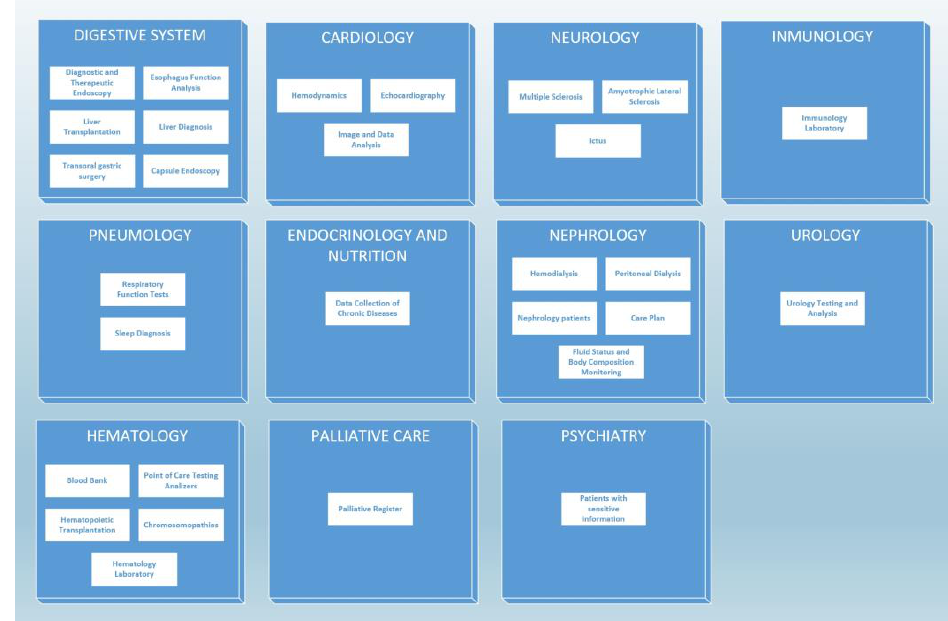
Figure 3. Relationship of information systems within clinical areas (I).